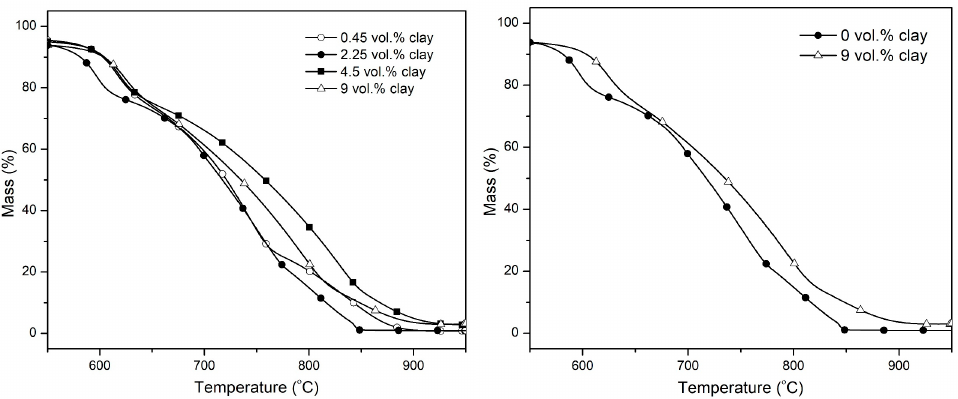
Figure 7. TGA degradation profiles of PI-NGS-Clay nanocomposites in air at a heating rate of 30 °C/min. 30 ◦ C/min.